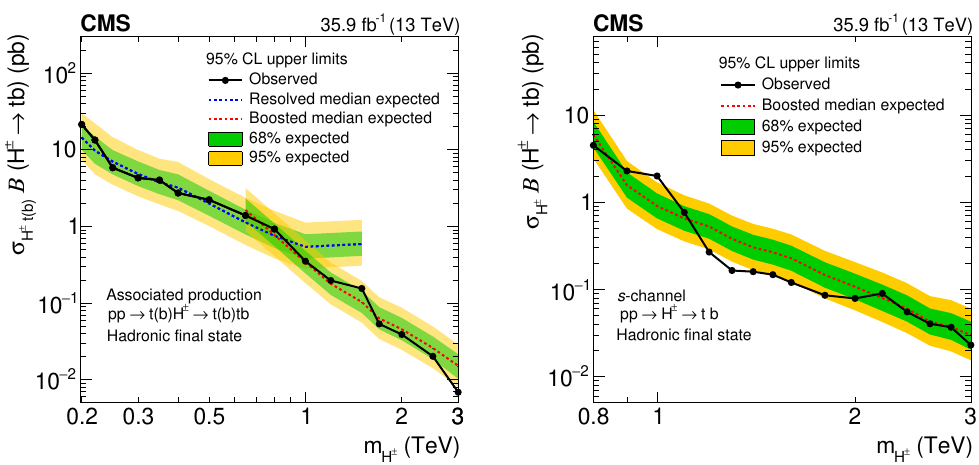
Figure 6 . Upper limits at 95% CL on the product of the H (cid:6) production cross section and branching fraction as a function of m for the associated (left) and s -channel (right) processes. The observed H (cid:6) upper limits are shown by the solid black markers. The median expected limit (dashed line), 68% (inner green band), and 95% (outer yellow band) con(cid:12)dence interval for the expected limits are also shown. For the association production model limits are calculated from the resolved (boosted) analysis for m points up to (greater than) 0.8 H (cid:6)